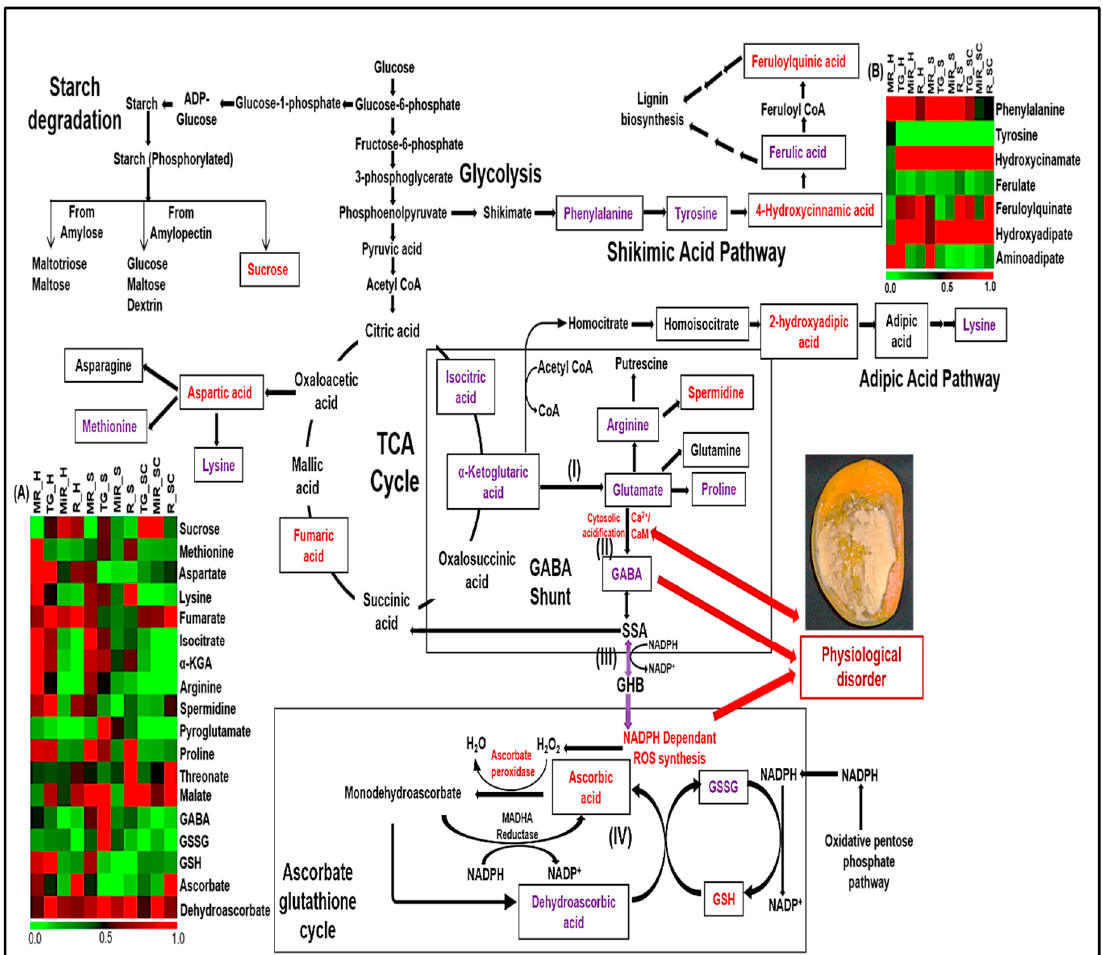
Figure 7. Probable pathways involved in spongy tissue formation. Ripening stage wise accumulation of each metabolite in all the three tissue sets is represented by heat map (MR: Mature raw, TG: Table green, MiR: Mid ripe, R: Ripe, H: Healthy, S: Spongy, SC: Spongy control). Heatmap ( A ) represents the putative metabolites from starch degradation, amino acid synthesis, TCA and ascorbate glutathione cycle whereas Heatmap ( B ) represents the metabolites from shikimic acid and adipic acid pathway. Metabolites identified in analysis are separated by box. Metabolites which are upregulated at the completely ripe stage of spongy tissue as compared to the healthy and the spongy control are represented in blue whereas downregulated metabolites are highlighted in red. Other metabolites are the components of respective pathways but are not identified in the current analysis. Black arrow indicates normal metabolic pathways whereas blue arrow (SSA to ROS synthesis) represents the probable metabolic variation which may induce physiological disorder. Pathways in which probable metabolic change occurs (GABA shunt and Ascorbate glutathione cycle) are highlighted separately. (Figure modified from [25]).